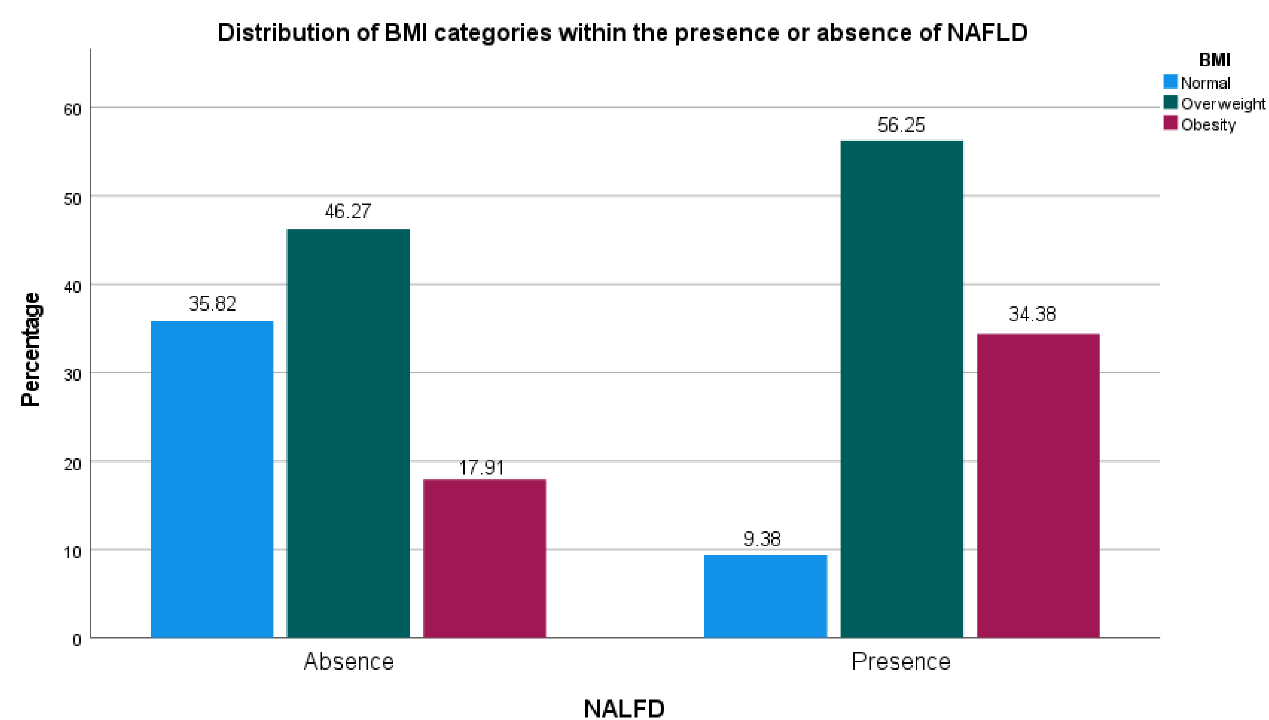
Figure 1. Relationship between BMI categories and the presence or absence of non-alcoholic fatty liver